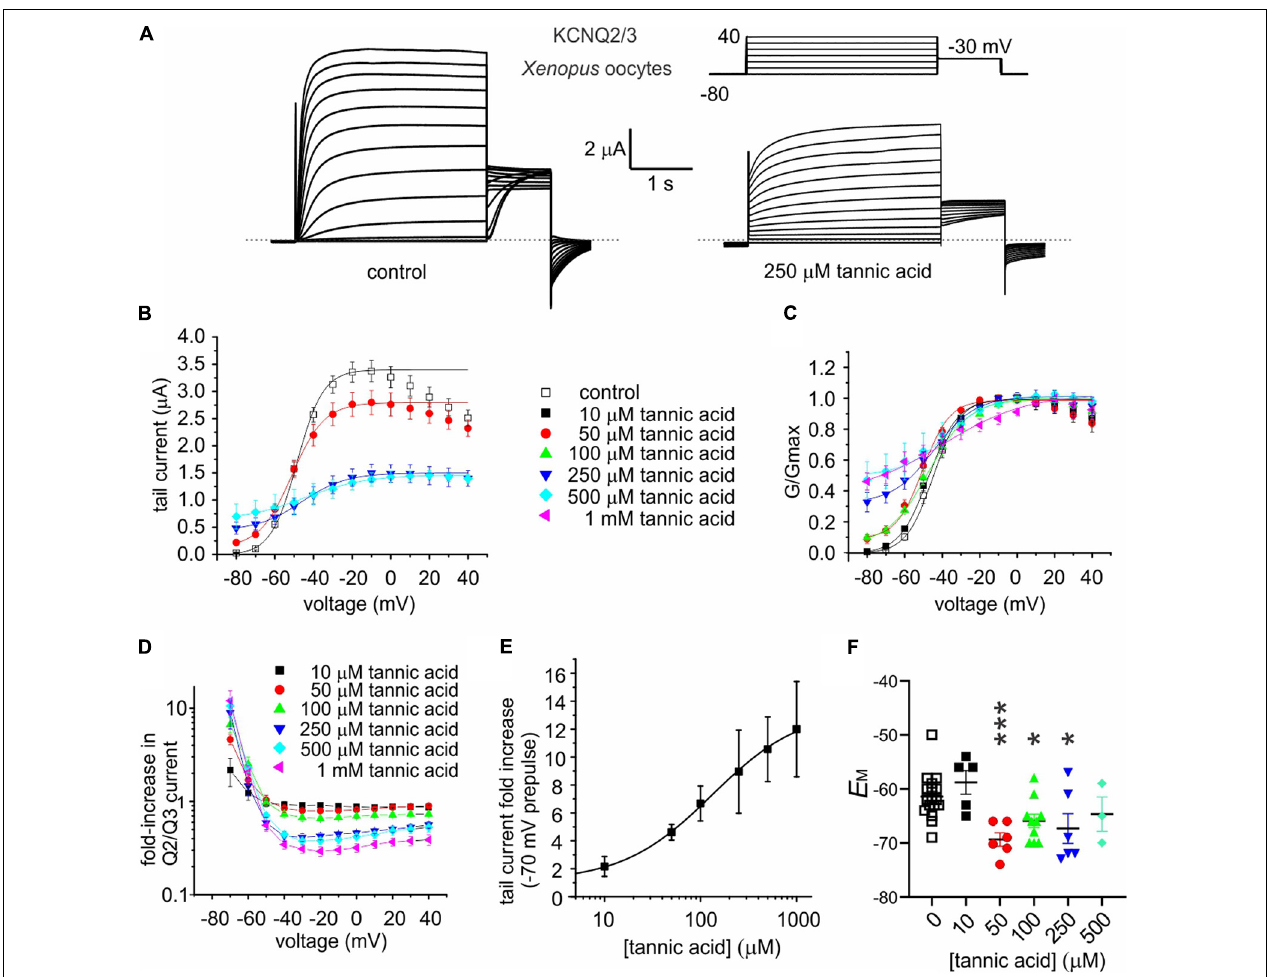
FIGURE 6 | Tannic acid exerts dual effects on KCNQ2/3 channels expressed in oocytes. All error bars indicate SEM. n = number of oocytes. (A) Exemplar TEVC traces of oocyte-expressed KCNQ2/3 in the absence (control) and presence of tannic acid (250 µ M). Upper right inset: voltage protocol. (B) Mean tail current versus prepulse voltage relationships for traces as in panel (A) at various tannic acid concentrations ( n : control, 17; 10 µ M, 5; 50 µ M, 6; 100 µ M, 10; 250 µ M, 6; 500 µ M, 3; 1 mM, 6). (C) Mean normalized tail currents (G/Gmax) versus prepulse voltage relationships for traces as in panel (A) at various tannic acid concentrations ( n as in panel B ). (D) KCNQ2/3 current fold-change versus voltage at various tannic acid concentrations for oocytes recorded as in panel (A) ( n as in panel B ). (E) Tannic acid dose response for KCNQ2/3 current increase at –70 mV for oocytes as in panel (D) ( n as in panel B ). (F) Scatter plot of unclamped membrane potential ( E M ) for cells as in panel (A) at various tannic acid concentrations ( n as in panel B ). Statistical analysis by one-way ANOVA. * p < 0 . 05; *** p < 0 .